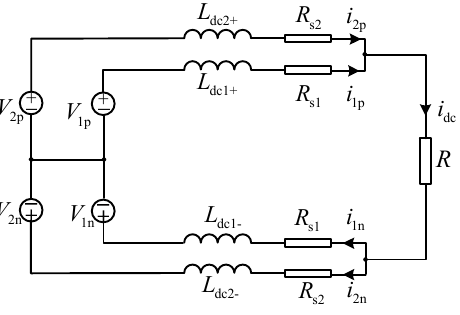
Figure 5. DC equivalent circuit.